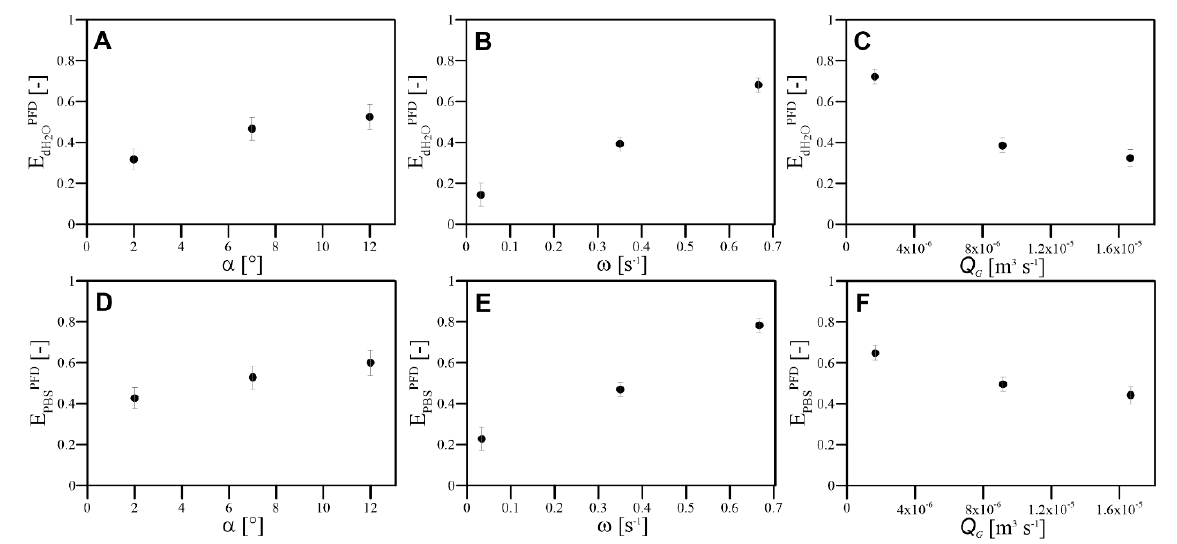
Figure 4. Graphical relationships between values of the E PFD factor characterizing both studied aqueous phases calculated for various values of α , ω , and Q G evaluated in the BBD: E PFD